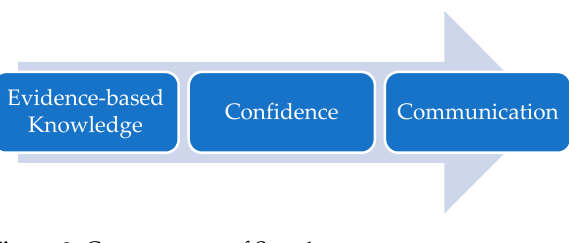
Figure 2. Core outcome of Step 1.